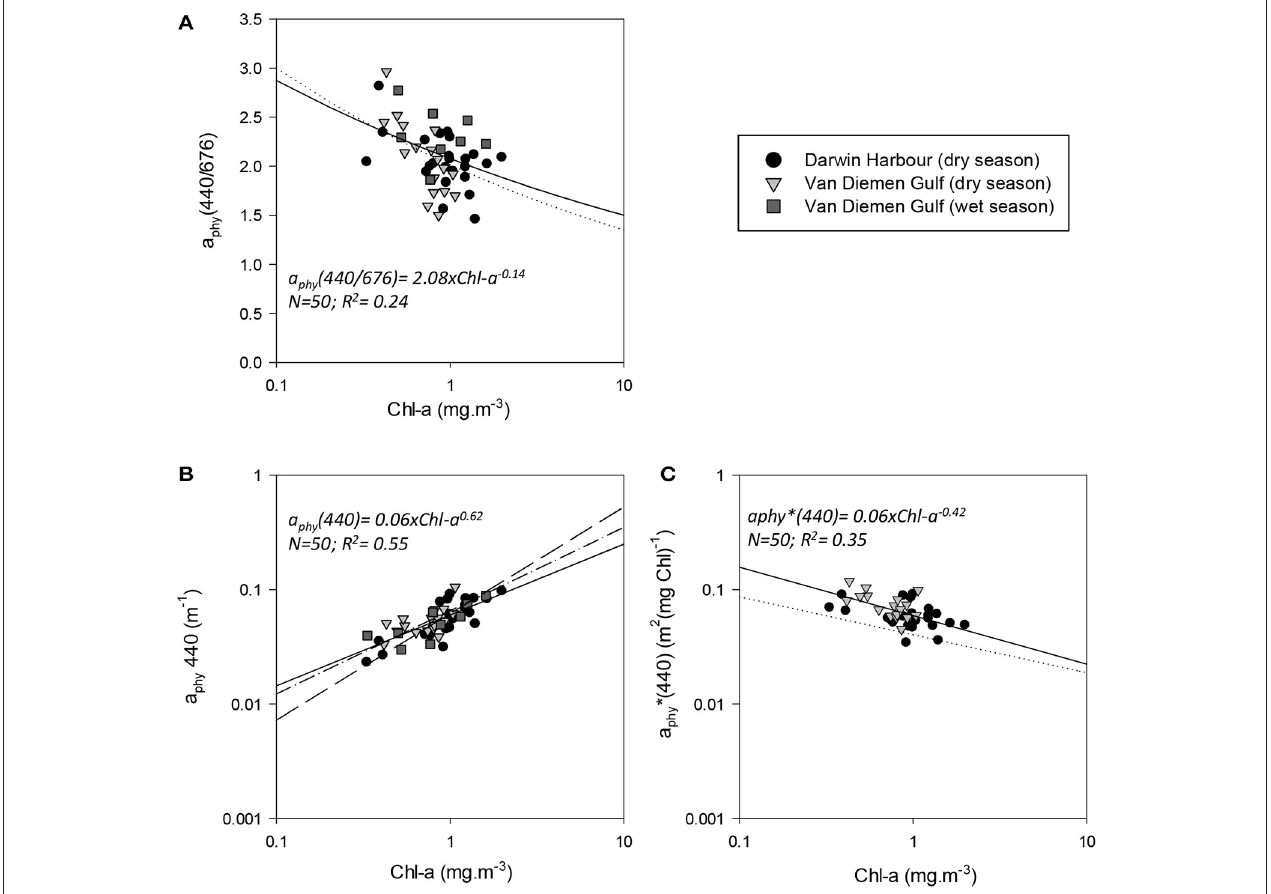
FIGURE 12 | Relationships between phytoplankton and Chl-a. Reference models from Bricaud et al. (1995) (A–C) dotted line; Bricaud et al. (2004) (B) dash-dot line, and Bricaud et al. (2010) long dash line are